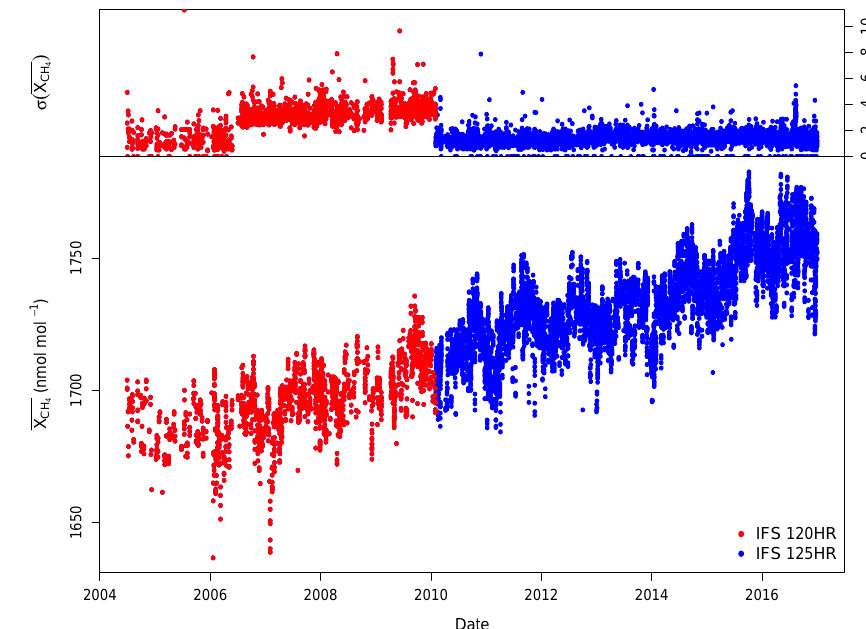
retrieved from measurements made with both FTS instruments at Lauder. 4